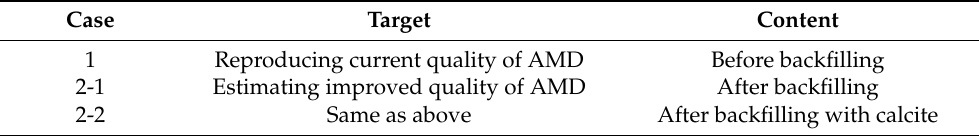
Table 1. Simulation